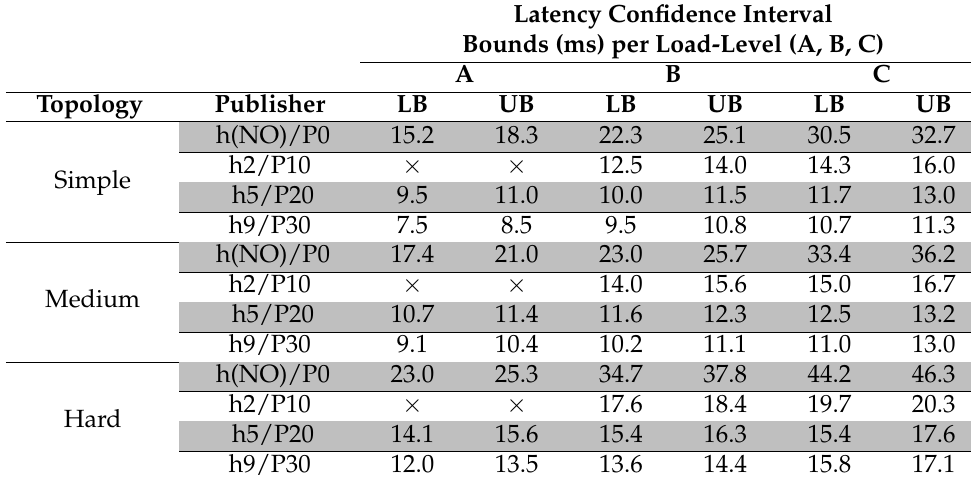
Table 4. Confidence Intervals (99% confidence) for TS and NO MQTT flows: